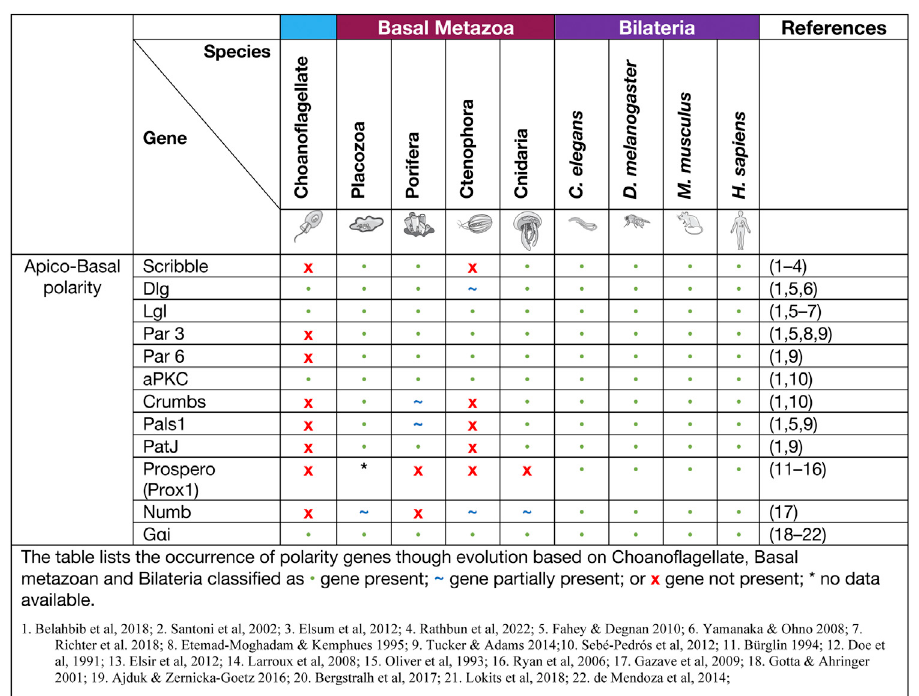
TABLE 1 Apico Basal Polarity